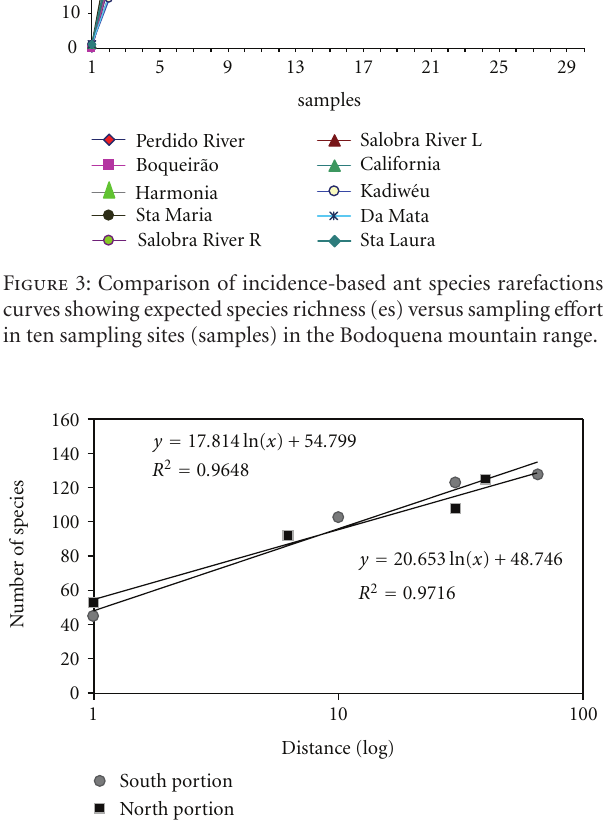
Figure 4: Ant species accumulation (logarithmic scale) in northern and southern portions in Serra da Bodoquena, Mato Grosso do Sul, Brazil. Obs: eight localities were considered, as collecting points III, IV, and IX were grouped as a single sample.